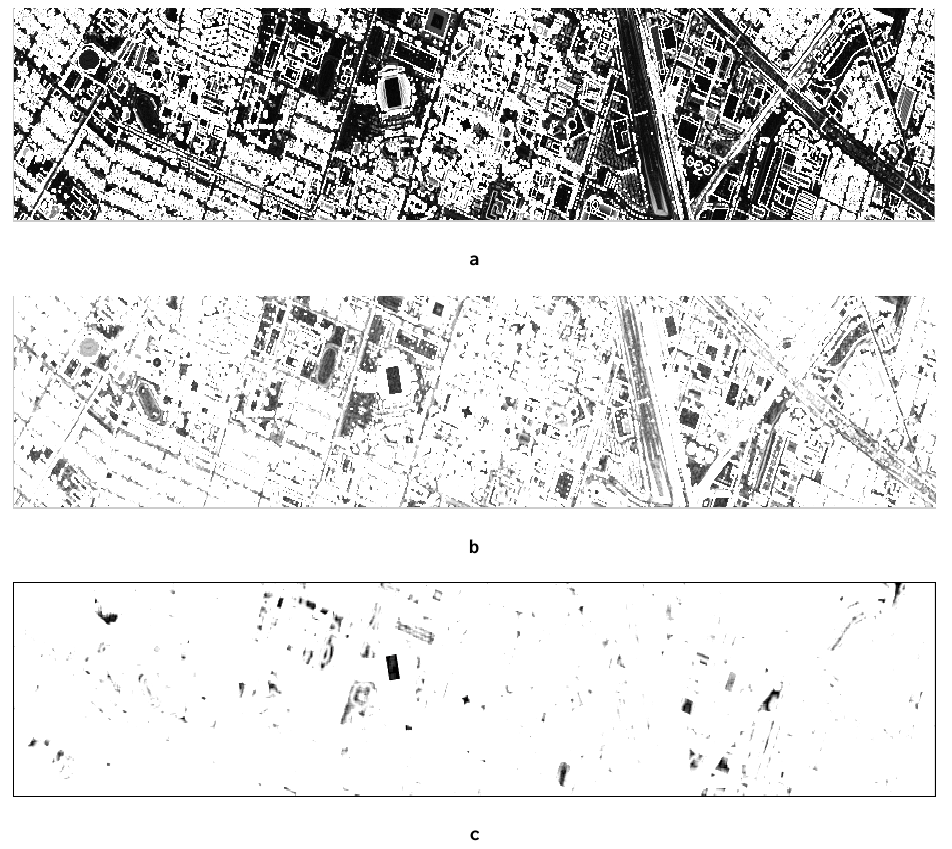
Figure 3. Some features on LIDAR data a)Standard deviation, b)Roughness,